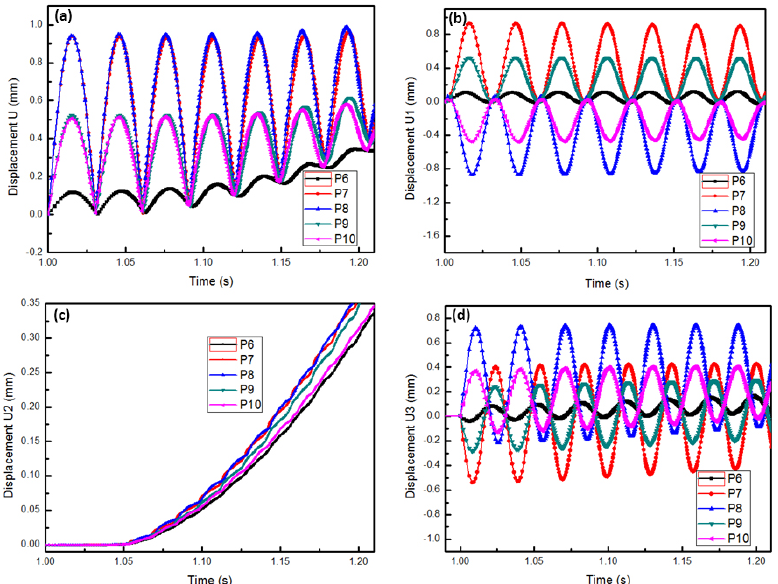
Figure 8. The characteristic point displacement-time curve: ( a ) U; ( b ) U1; ( c ) U2; ( d ) U3.